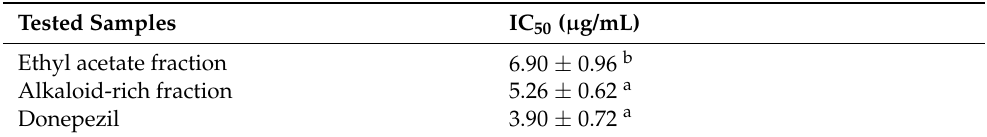
Table 3. Acetylcholinesterase inhibitory activity of A. lucidior ethyl acetate fraction vs its alkaloid- rich fraction.